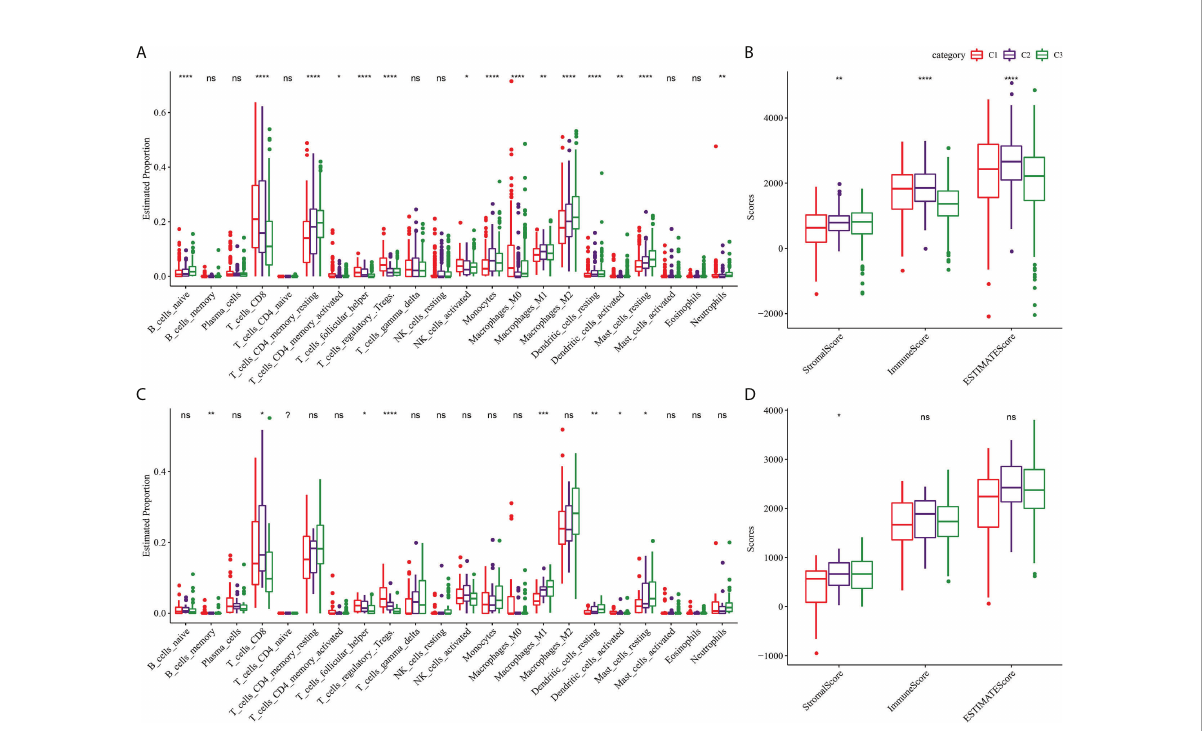
FIGURE 4 TME characterization of three clusters. (A) The proportion of immune cells in the three subtypes of TCGA-KIRC dataset. (B) Stromal score and immune score and ESTIMATE score among three subtypes in TCGA-KIRC dataset. (C) The proportion of immune cells among the three clusters of the ICGC dataset. (D) Differences of stromal score, immune score, and ESTIMATE score among three clusters of ICGC dataset. * P < 0.05, ** P < 0.01, *** P < 0.001, **** P < 0.0001. ns, not signi fi